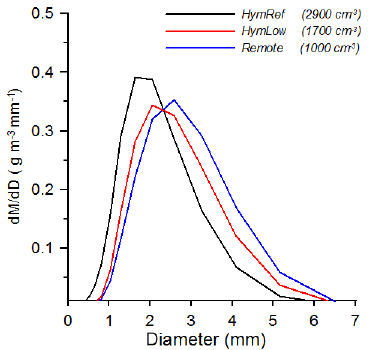
Figure 14. Mean mass distributions of raindrops simulated for all surface elevations between 500 and 600ma.s.l in the third model